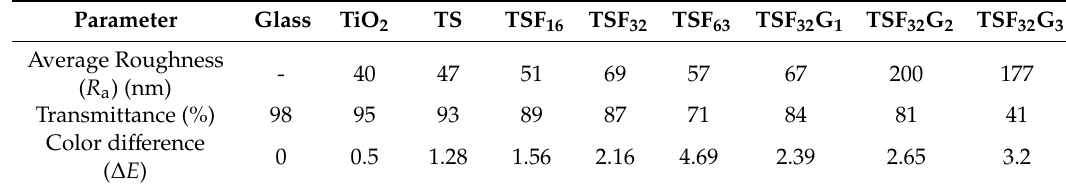
Table 4. Average surface roughness R a , transmittance in the region 380–740 nm, and ∆ E caused